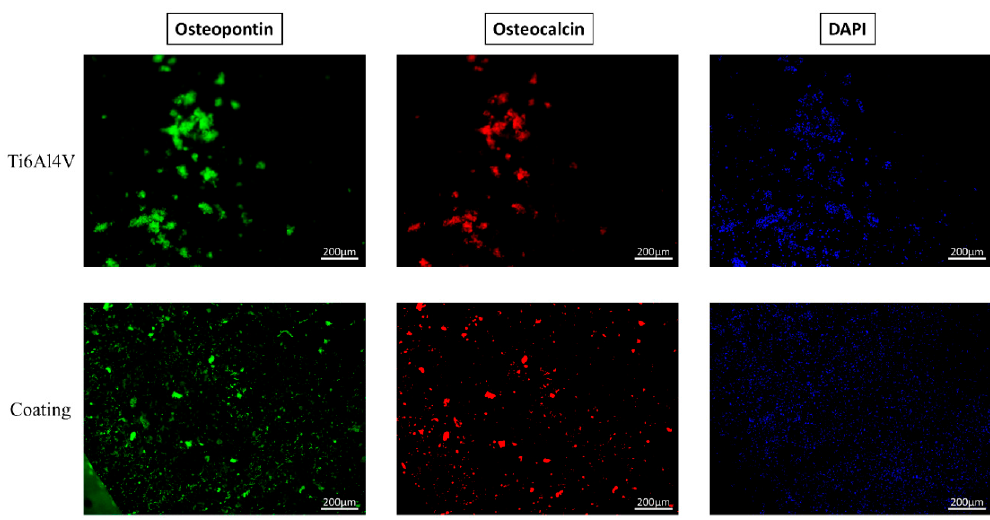
Figure 9. Ti6Al4V fluorescence micrograph samples after exposure to SaOS-2 cells. Green and red stains identify osteocalcin and osteopontin, respectively, while blue shows cell nuclei.